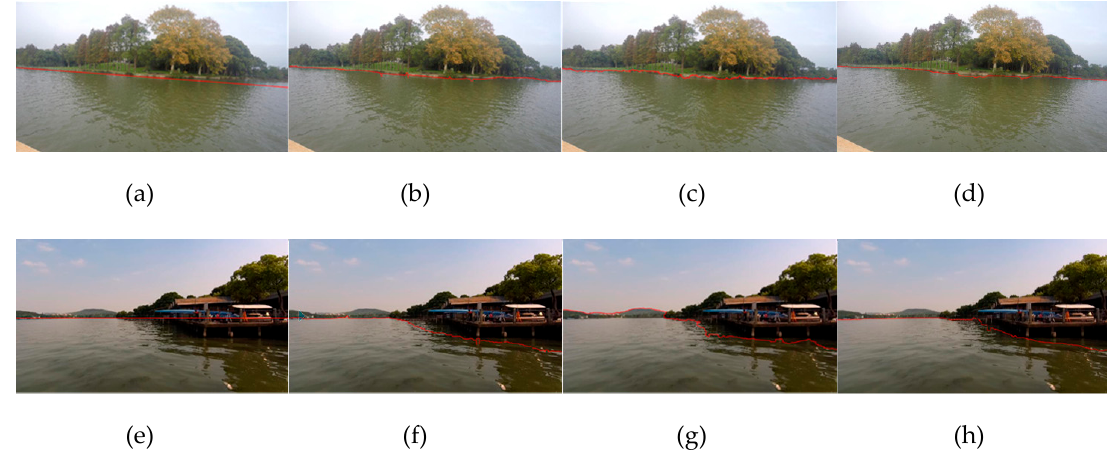
Figure 20. The WSL detection results of four different algorithms: ( a )–( d ) are experimental results